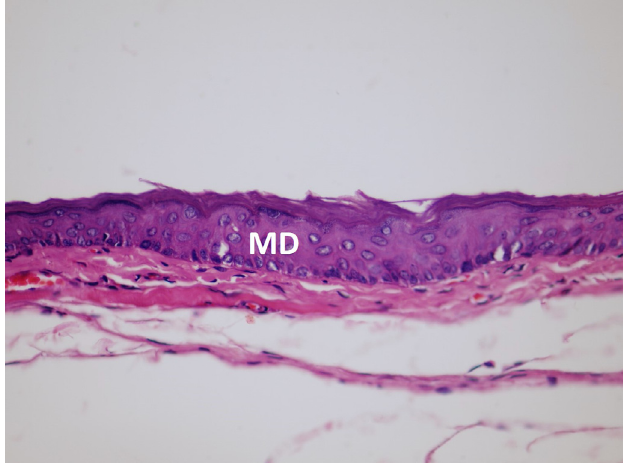
Fig. 5. Shows hematoxylin and eosin-stained cheek pouch section from an animal treated for 2 weeks with Nigella sativa (NS) followed by NS and 7,12-dimethylbenza[a]anthracene (DMBA) for 6 weeks. Mild dysplasia (MD) is noted. Magni fi cation: 20 (cid:1)